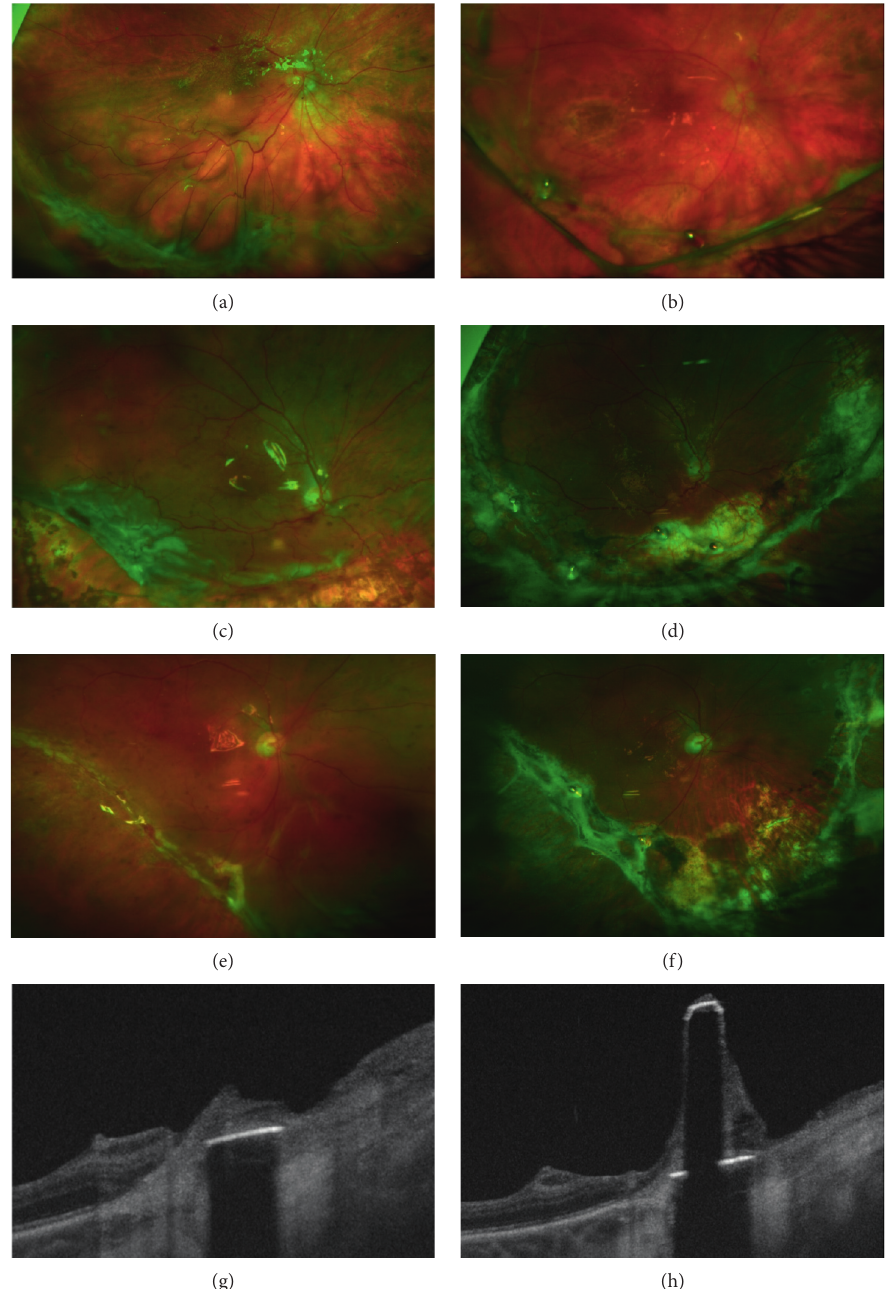
Figure 2: Ultra-widefield scanning laser ophthalmoscopy. Fundus photography of patient 1 before surgery (a) and 5 weeks after surgery (b). 2 retinal tacks (RT) are placed at 6 o’clock and 7: 30 positions. A fibrous reaction at the RTsitus and along the retinectomy is seen. The retinectomy borders are not detached, and the fibrous strands are held by RTs. Fundus photography of patient 3 before surgery (c) and 6 months after surgery (d). 4 RTs are placed at 5:30, 6, 7, and 8 o’clock positions. A fibrous reaction involves RTs and retinectomy borders. Fundus photography of patient 8 before surgery (e) and 11 months after surgery (f). 2 retinal RTs were placed at 6: 30 and 8 :30 positions to reattach the stiff retina of the retinectomy border close to the macula. Retinectomy borders are not everted after surgery, despite fibrous reaction (b, d, f). Swept-source optical coherence tomography (SS-OCT) scans with segmentation of the RTin patient 11 (g, h). SS-OCTof the RT shows a fibrous reaction around the tack and on the tack’s